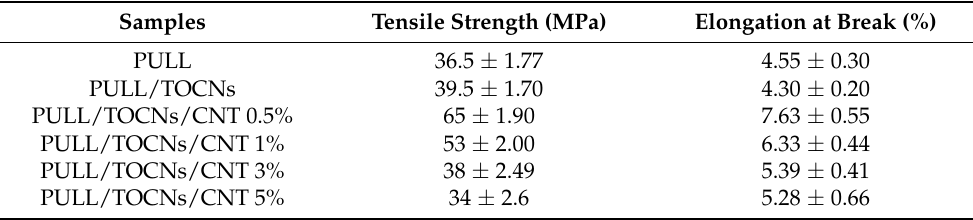
Figure 8. The ( a ) visible light transmittance and ( b ) electrical conductivity of the neat PULL and PULL/TOCNs/CNT nano- composite films.